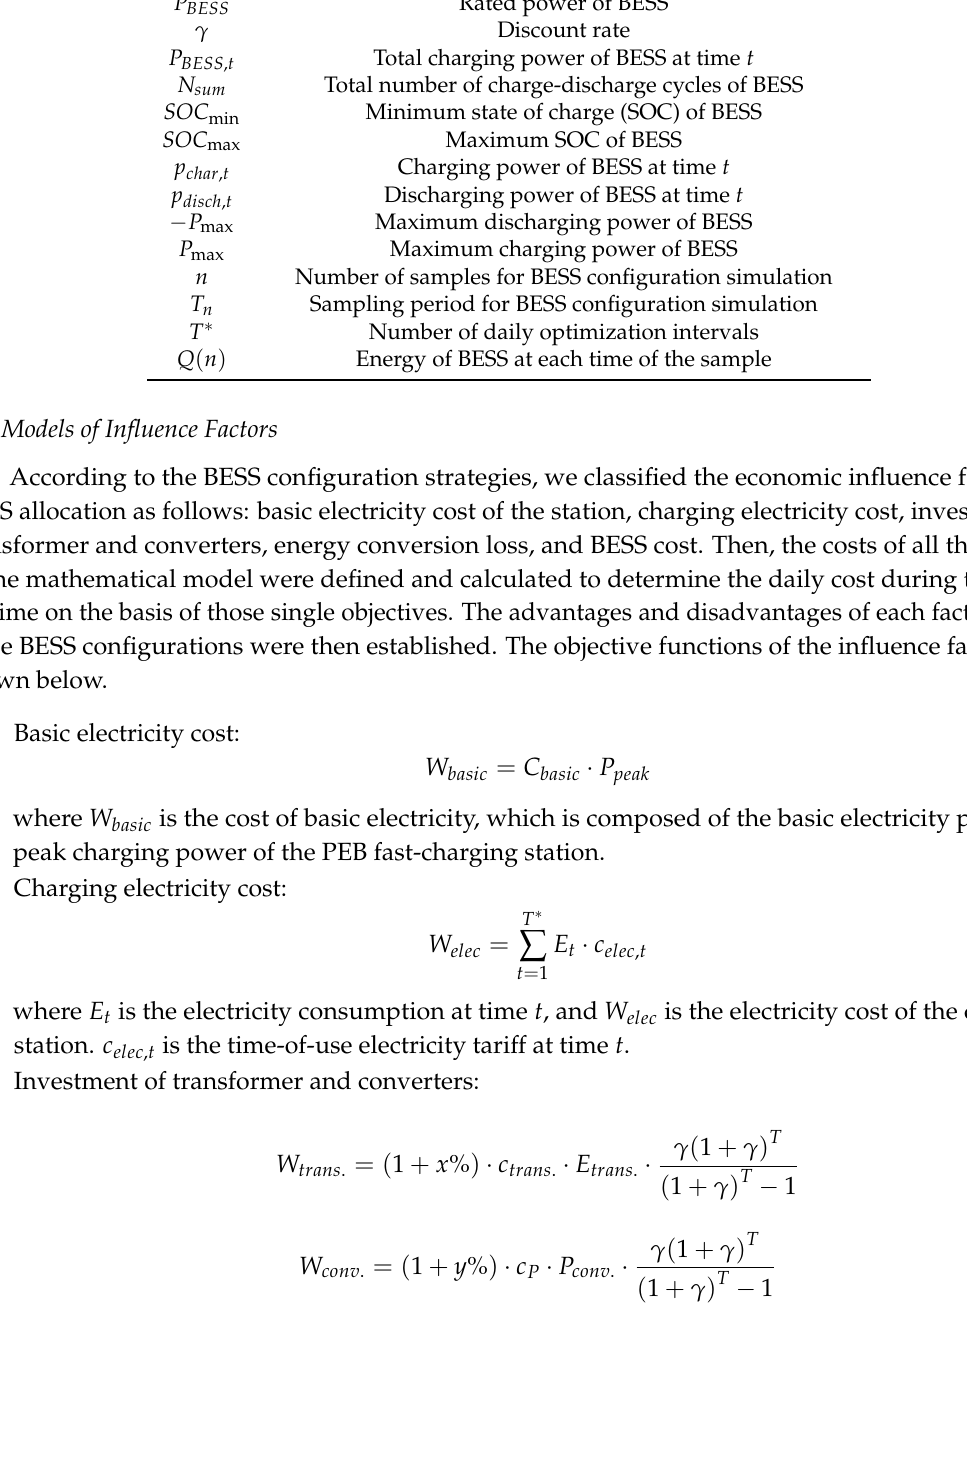
Table 1. List of some symbols used in the description of the BESS configuration. Symbol Explanation x % Ratio of operation and maintenance cost of the transformer y % Ratio of operation and maintenance cost of the converters z % Ratio of operation and maintenance cost of the batteries c E Cost of the BESS’s unit battery energy Cost of the BESS’s unit converter power Rated capacity of BESS Rated power of BESS Discount rate Total charging power of BESS at time t Minimum state of charge (SOC) of BESS